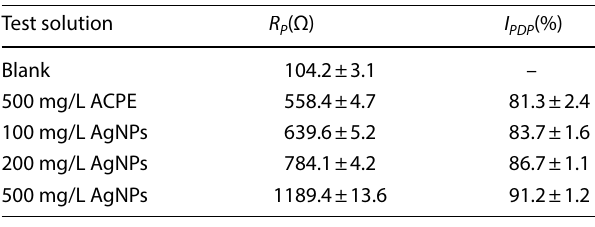
Table 4 LPR parameters for the inhibition of X80 steel corrosion in 1 M HCl containing ACPE and different concentrations of its Et- AgNPs